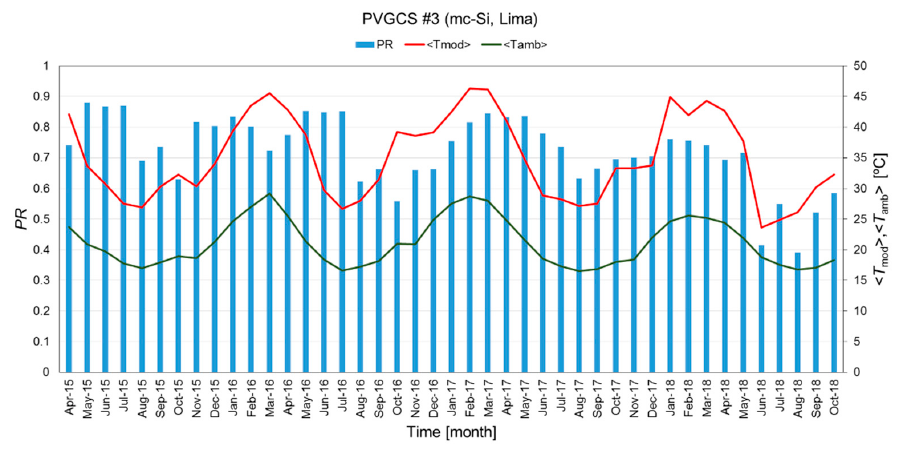
Figure 8. Values of PR , < T amb >, and < T mod > for PVGCS #3 over the period under scrutiny. N.B. only values of temperature recorded during daytime are considered in the calculations.